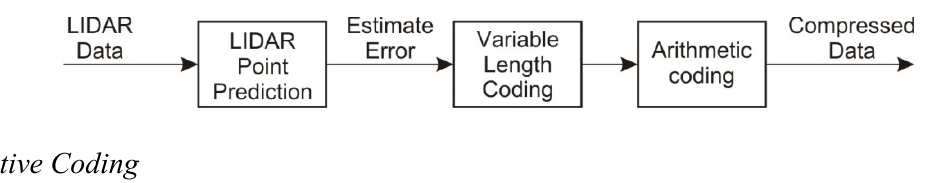
Figure 2. The structure of LAScompression